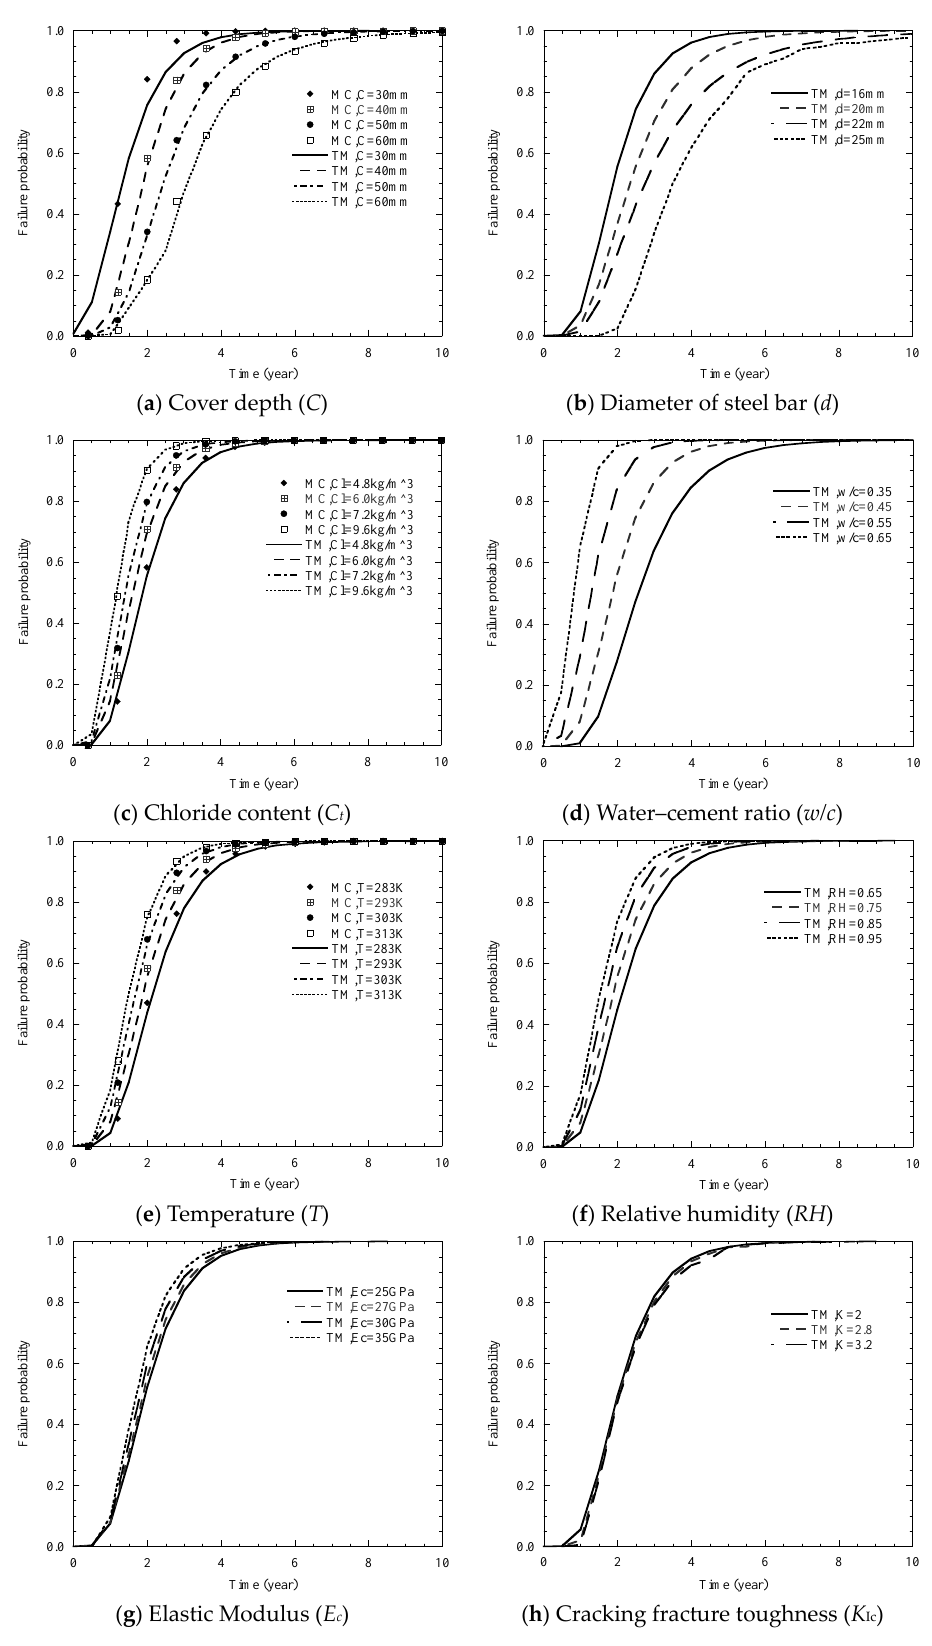
Figure 9. Influence of the mean values of different factors on the failure probability of cover cracking.